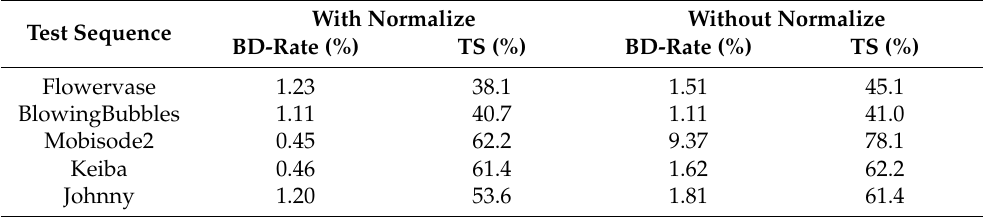
Table 4. The encoding performance of the proposed normalizing method with HM 16.22.